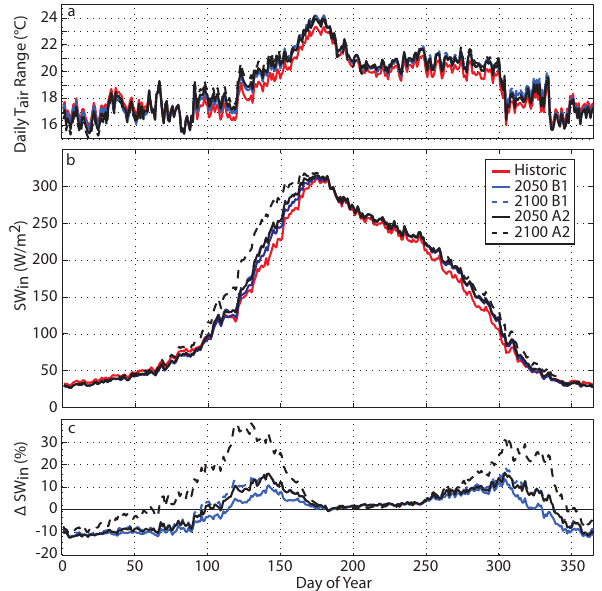
Fig. 6. (a) Daily average temperature range and (b) daily average incoming shortwave radiation under current and future climate sce- narios; (c) daily average change in incoming shortwave